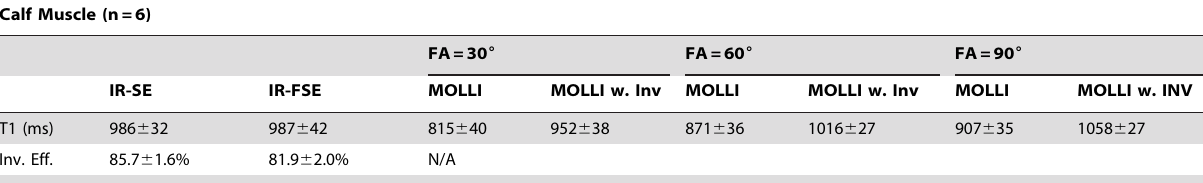
Calf Muscle (n=6)